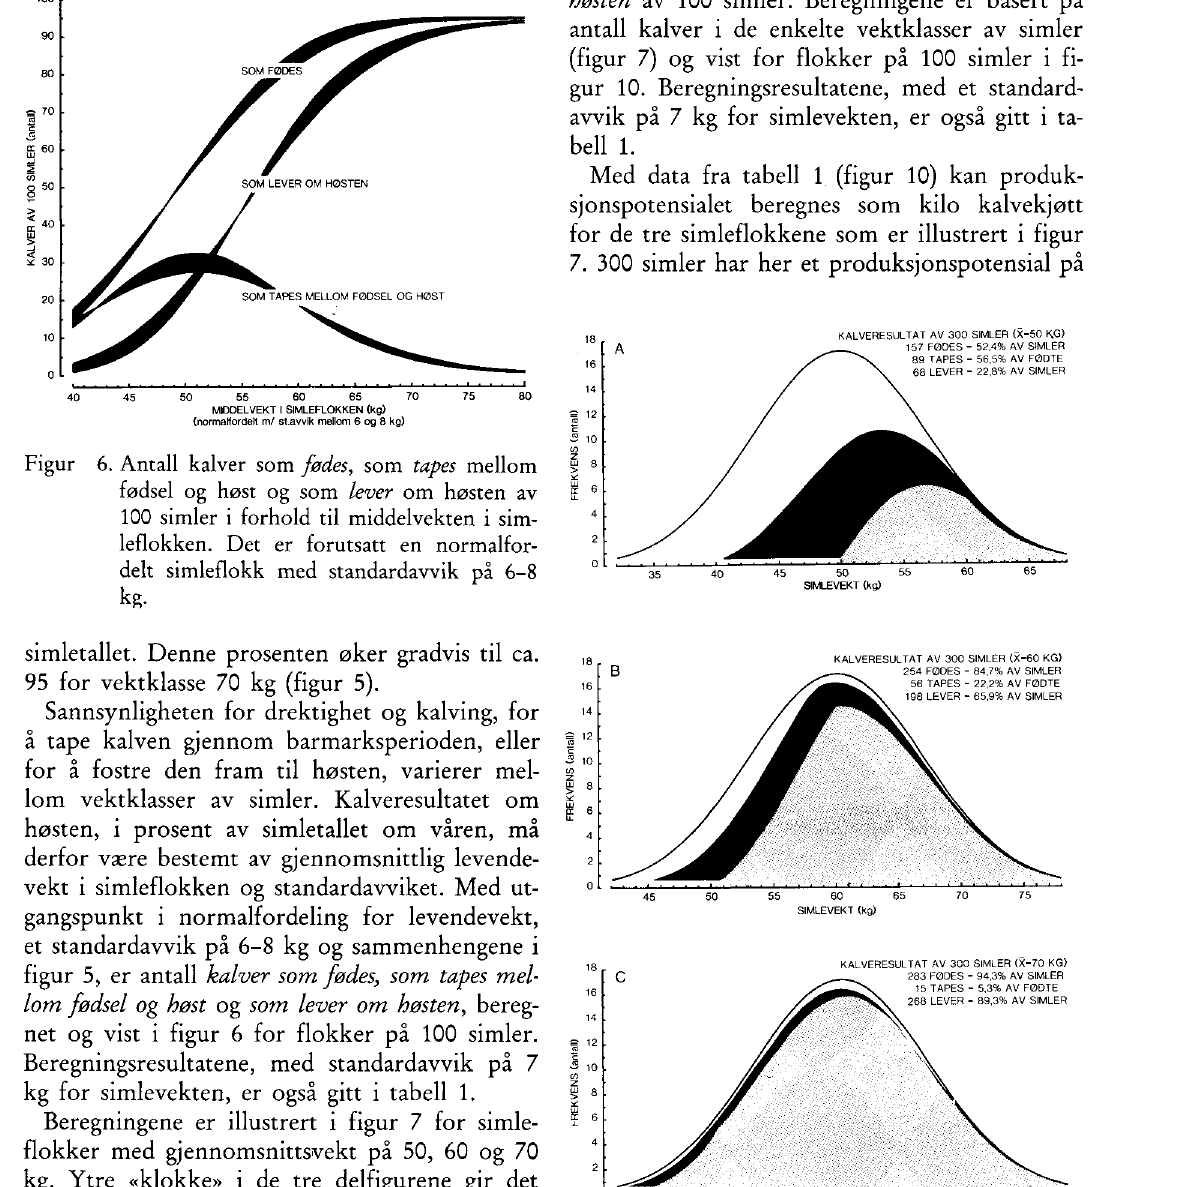
Figur 7. Illustrasjon av tre simleflokker med gjenn omsnittsvekt på 50, 60 og 70 kg. Ytre «klokke» i delfigurene gir det